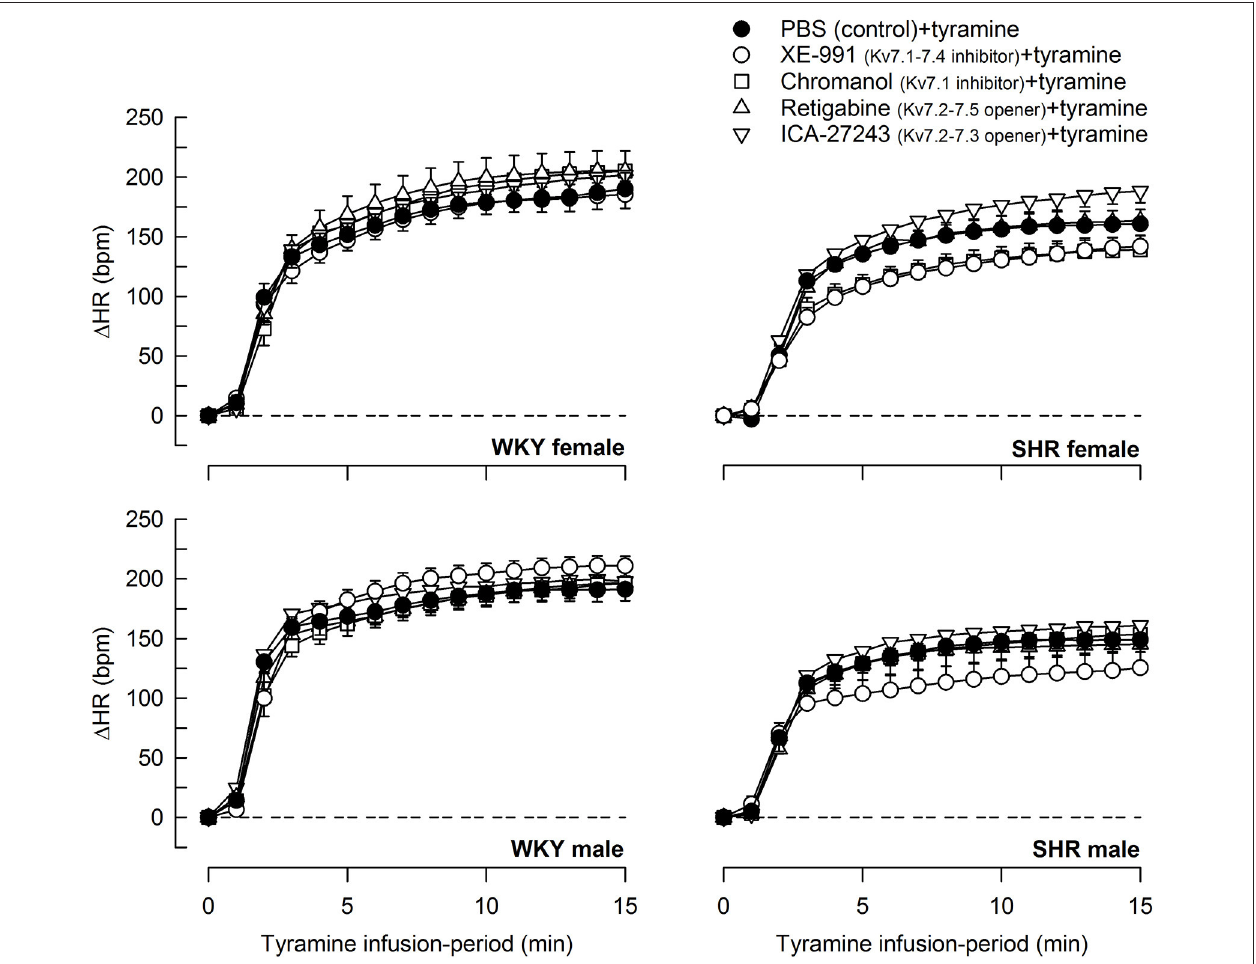
FIGURE 7 | The effect of Kv7 inhibitors/openers on the HR-response to tyramine-stimulated norepinephrine release. The rats were pre-treated as indicated by symbol legends. In the order of symbol legends, HR prior to tyramine = 354 ± 12, 342 ± 6, 350 ± 9, 330 ± 19, 372 ± 11 bpm, 341 ± 8, 329 ± 7, 355 ± 7, 330 ± 9, 342 ± 14 bpm, 347 ± 11, 326 ± 8, 351 ± 7, 332 ± 8, 353 ± 6 bpm, and 379 ± 6 † , 356 ± 9, 397 ± 17, 368 ± 9, 381 ± 11 bpm in female WKY and SHR and male WKY and SHR, respectively ( † P ≤ 0.0125 for a sex-difference in the baselines in SHR. Strain- or drug-related differences were not detected). The HR-response curves to tyramine were analyzed using Repeated Measures Analyses of Variance and Covariance, followed by one- and two-sample Student’s t -tests or Kruskal–Wallis tests (please see the Materials and Methods section for details). The HR-response to tyramine at 15min was significantly different from baseline in all groups ( P ≤ 0.001, not indicated). Significant differences between the control and the drug-treated experimental groups at 15min were not